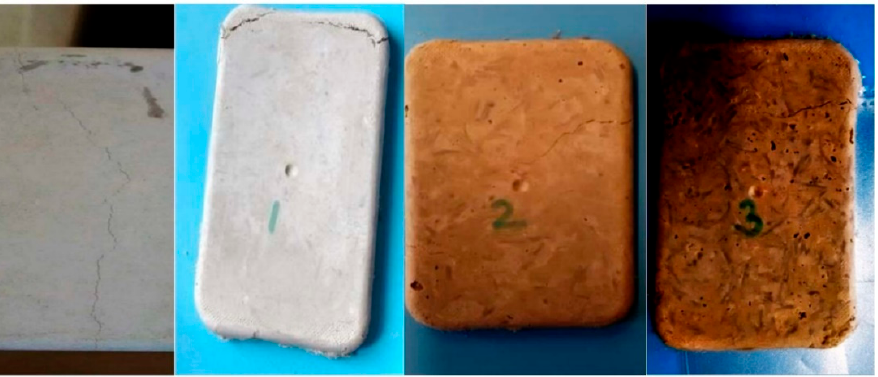
Figure 10. Crack patterns in 0%, 1%, 2%, and 3% basalt-fiber-reinforced concrete samples after tensile testing (pictures formatted so that crack patterns are clearer).